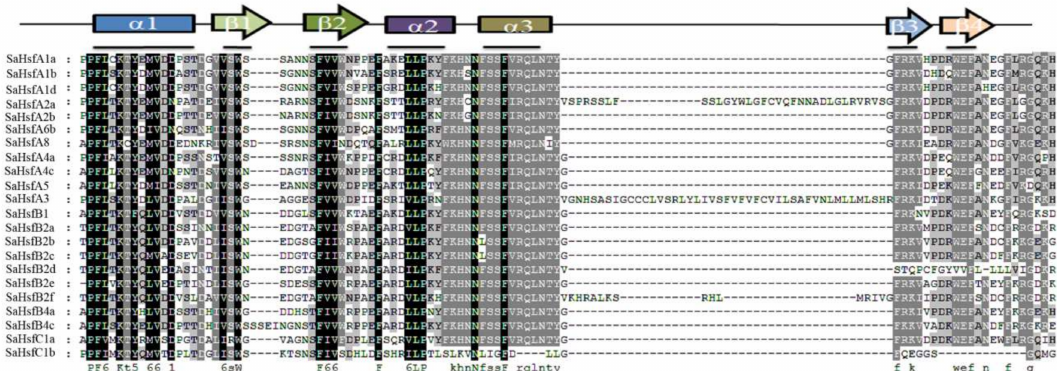
Figure 2. Multiple sequence alignment of the DNA-binding domain (DBD) of the Hsf protein family in S. alfredii . The different backgrouds, black and gray, indicated completely and partly conserved amino acids in proteins, respectively.